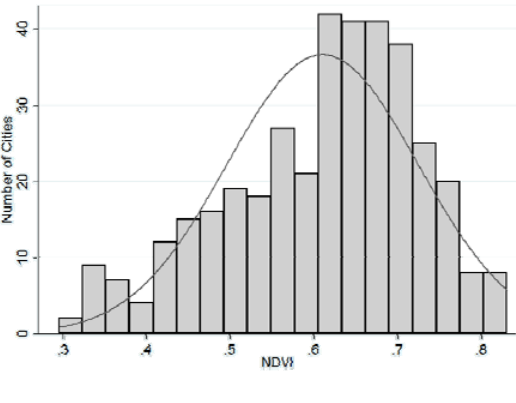
Figure 3. Distribution of c ities in terms of vegetative density. The solid line represents a normal density curve of the data. Higher values indicate dense vegetation, lower values indicate sparse vegetation.